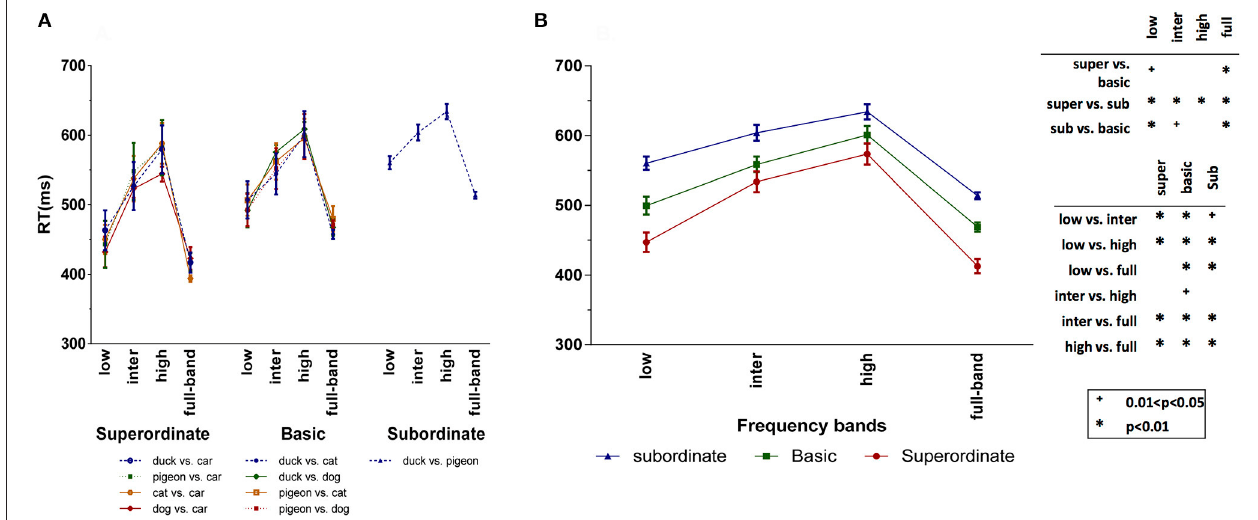
FIGURE 5 | Subjects’ mean RT for different categorization levels and spatial frequency bands. (A) Subjects’ RT for the different tasks of each categorization level. (B) Average RT over the different tasks of the superordinate (duck vs. car, pigeon vs. car, cat vs. car, and dog vs. car), basic (duck vs. cat, duck vs. dog, pigeon vs. cat, and pigeon vs. dog) and subordinate (duck vs. pigeon) levels. The p -value matrix presents the significant and strongly significant values using + and * signs, respectively. Error bars represent standard error of the mean (SEM). The between (within) group df is 11